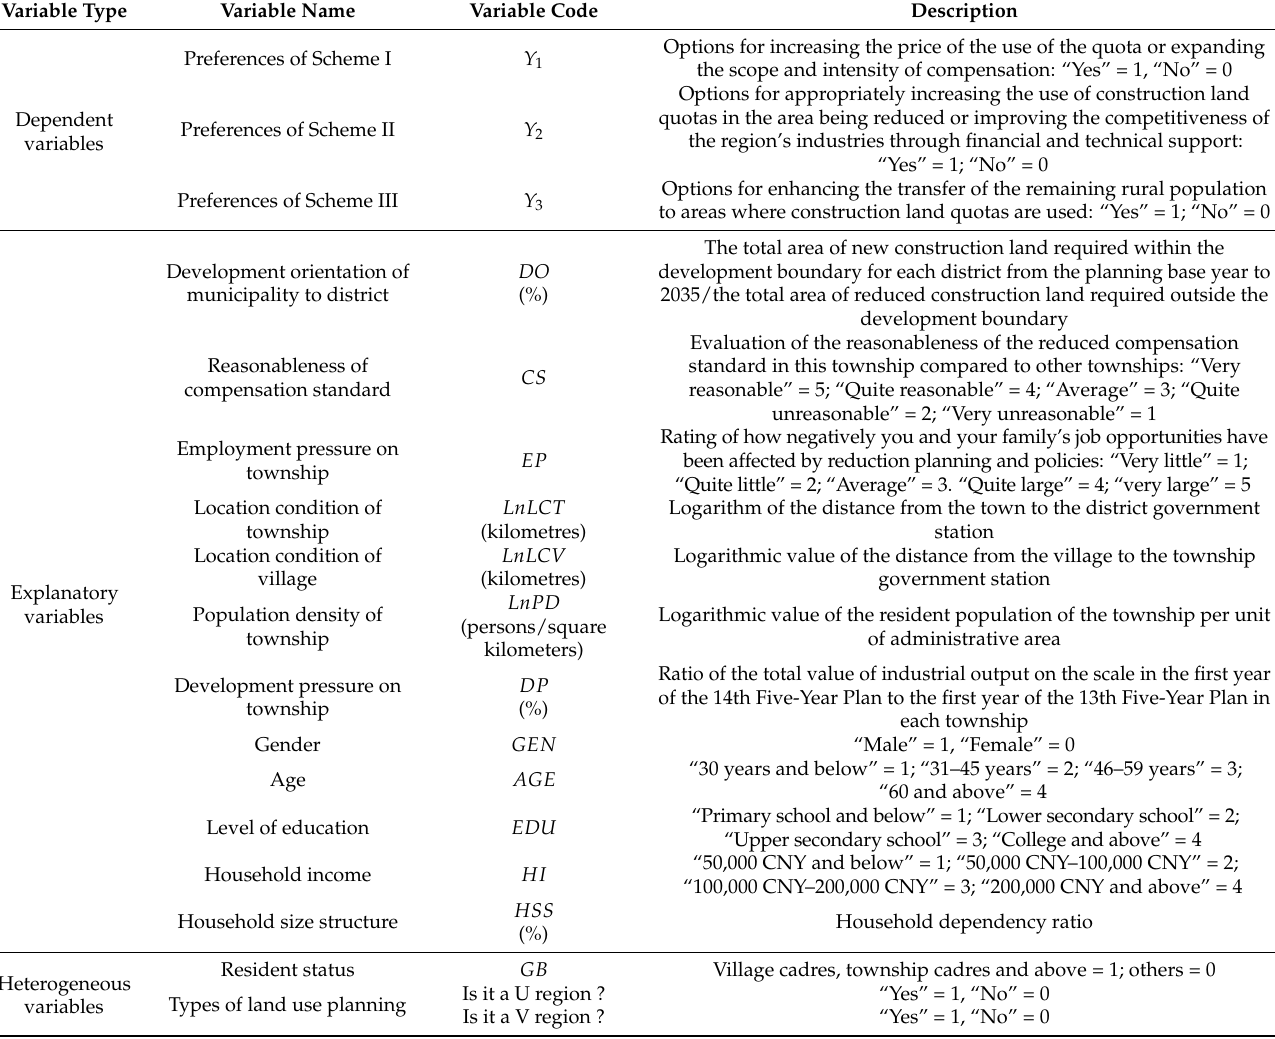
Table 3. Description of model